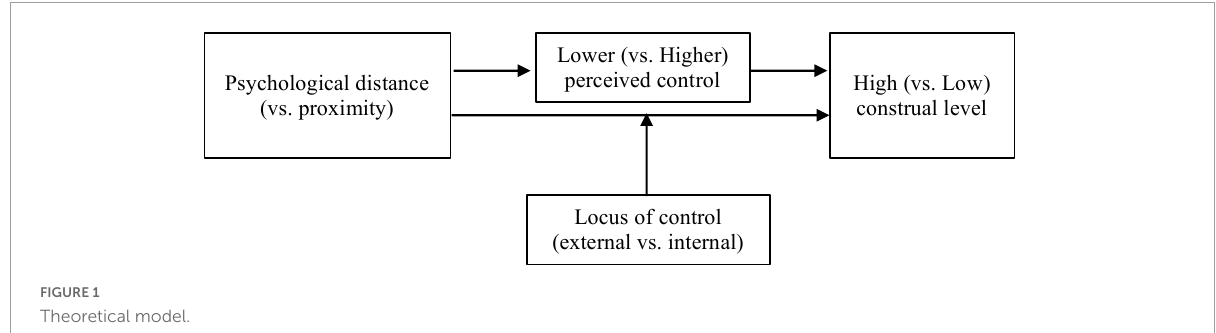
FIGURE1 Theoretical model.